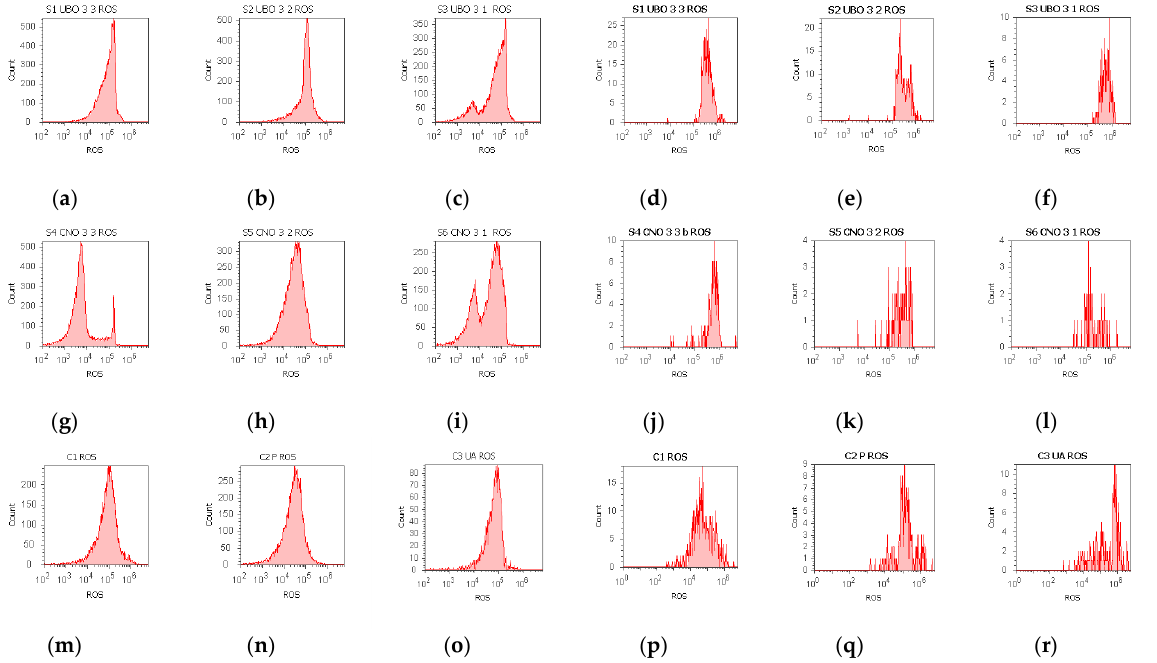
Figure 4. Total ROS activity in blood cells ( a – c , g – h , m – o ) and CLS-354 tumor cells ( d – e , j – k , p – r ) after 24 h exposure to different concentrations [3:3; 3:2; 3:1] of U. barbata extract in canola oil (UBO) ( a – f